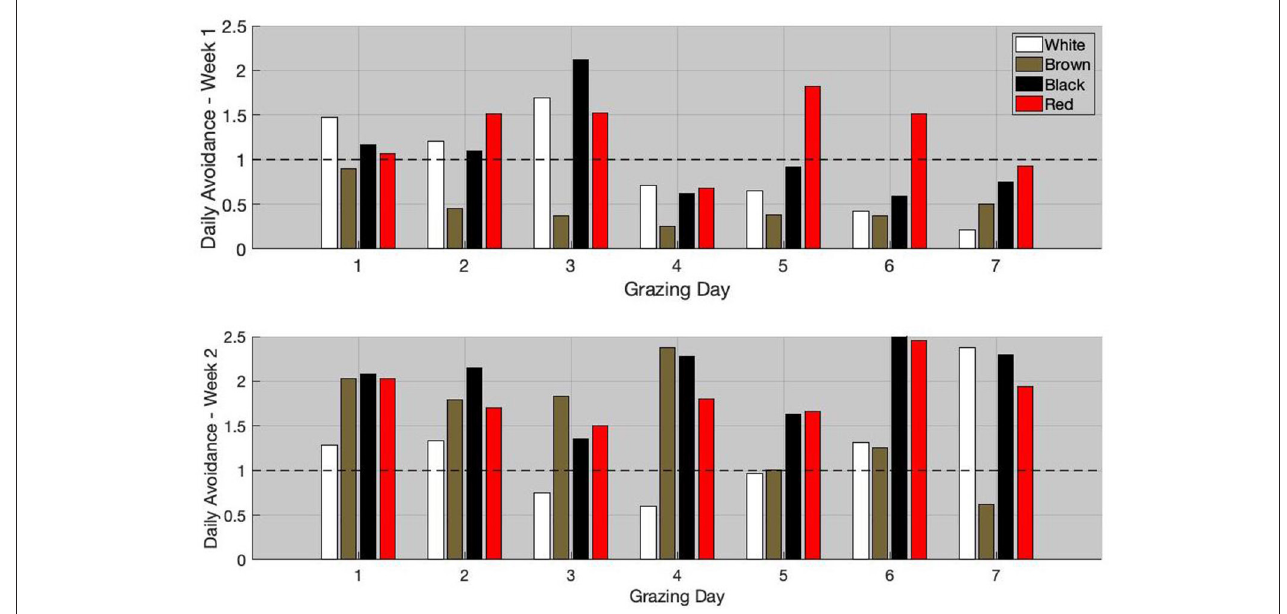
FIGURE 5 | Individual daily avoidance for week 1 (top) and week 2 (bottom)